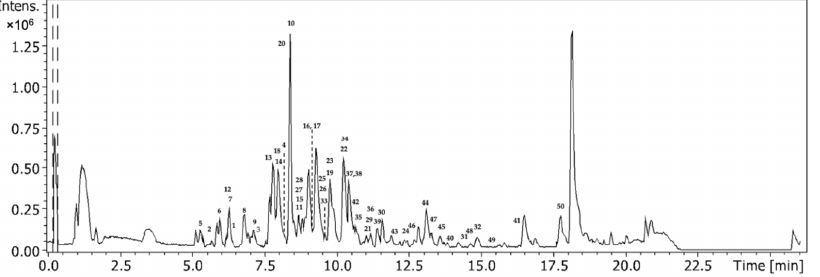
Figure 1. Base peak chromatogram (BPC) from sugarcane straw ethanolic extract (50% EtOH). Numbers 1-50 represent the identified compounds as described in Table 1.